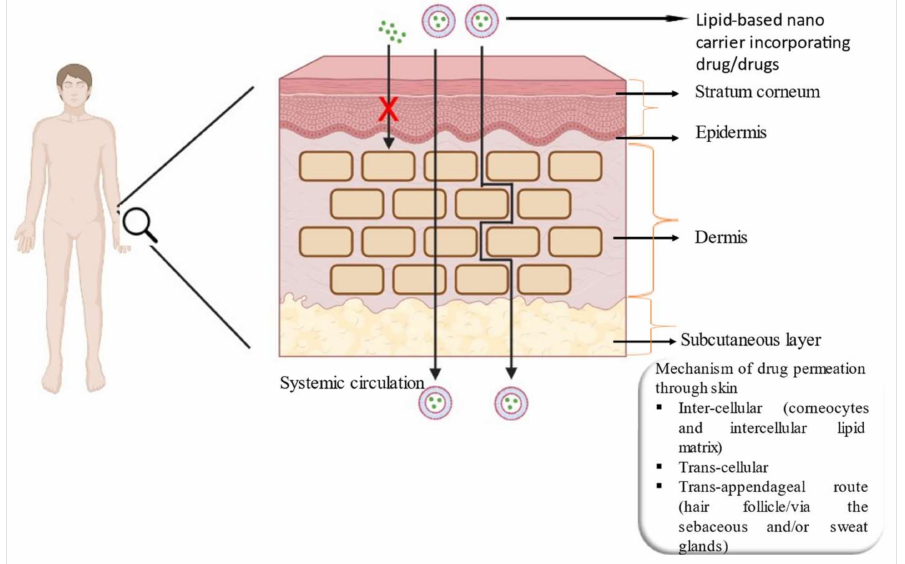
Figure 2. The structure of the skin depicting different mechanisms of drug permeation through